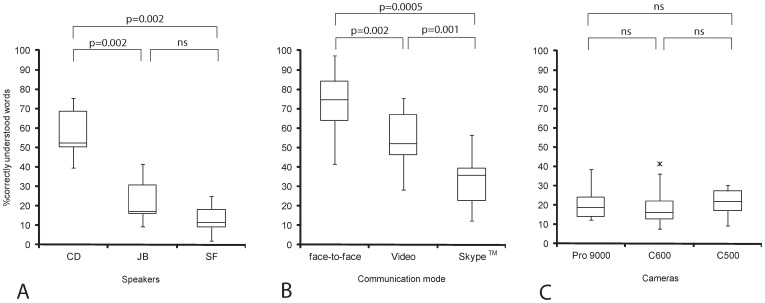
Boxplots demonstrating lower quartile, median, and upper quartile, and whiskers representing 1.5 times the interquartile range (X = outliers): Speech reading performance (correctly-repeated words in percent) from 14 deaf individuals by using (A) the same high definition web camera (Logitech Pro9000) and different speakers (CD, medical student, 97 words/s; JB, actress, 161 words/s; SF, speech therapist, 178 words/s), (B) the same speaker (CD) but different communication modes and (C) the same speaker (SF) with 3 different webcams: Logitech Pro9000, Logitech C600, and Logitech C500.